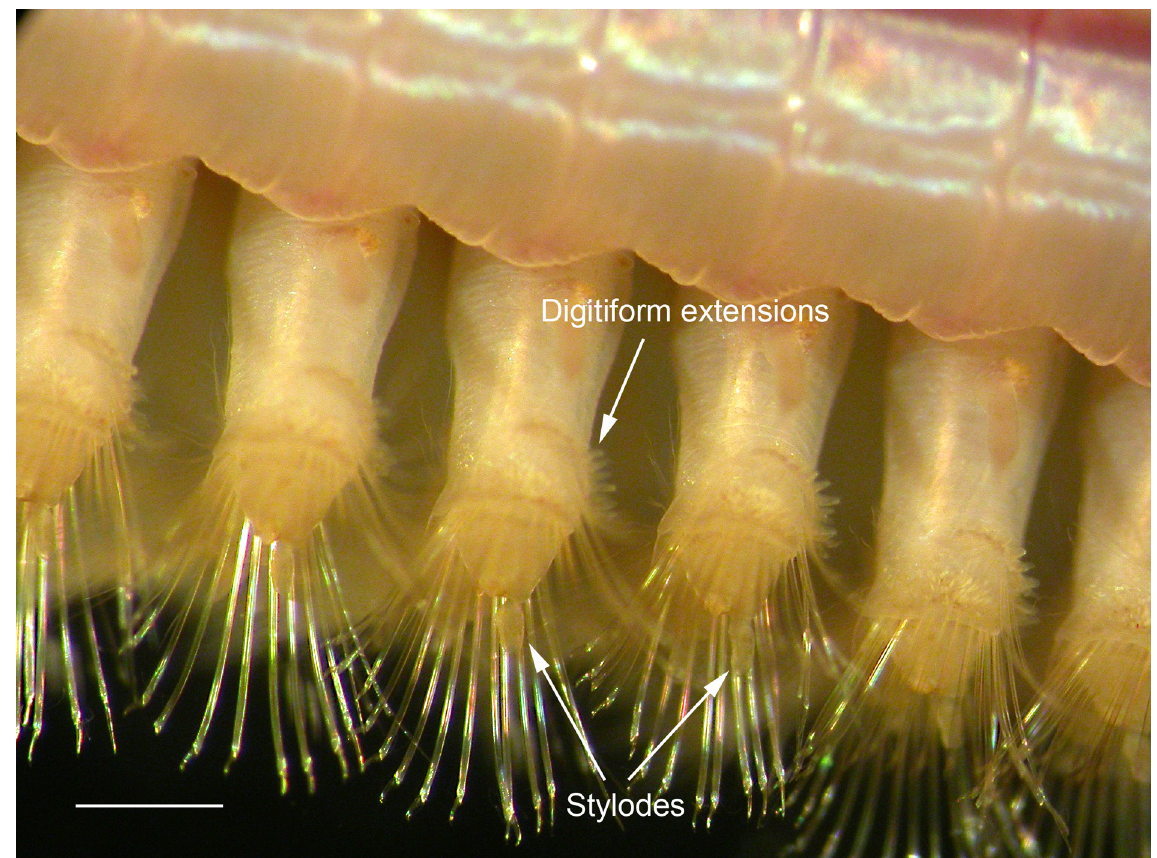
Fig. 3. Stylodes and digitiform extensions on parapodia of Sthenelais boa (Johnston, 1833), ventral view (photograph by D. Fiege, Senckenberg Museum). Scale bar: